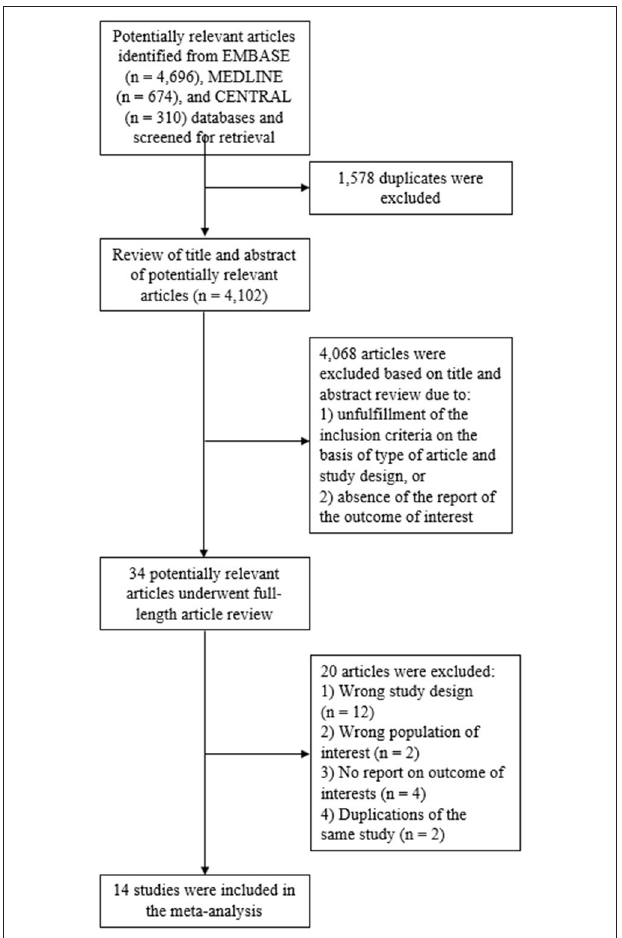
FIGURE 1 | Study identification and literature review